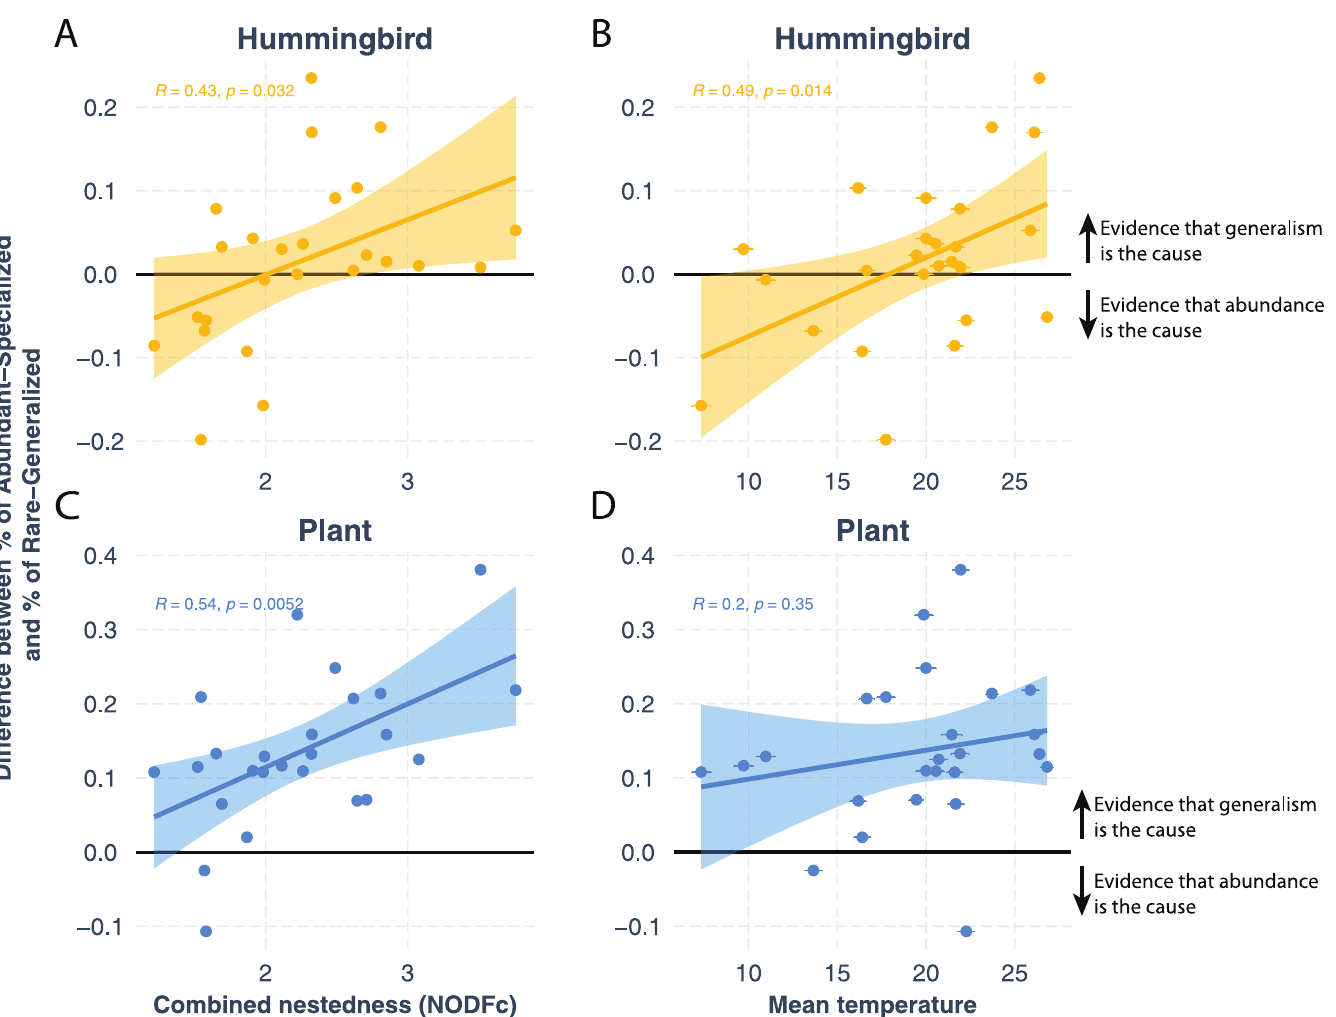
Fig 4. Strength of selection process versus drift process under structural and environmental context. Panels ( A ) and ( C ) show the effects of the structural context. The x axis shows the combined nestedness, which is an unbiased metric to compare the level of nestedness across networks [47, 50]. The y axis shows the differences between the proportion of abundant and specialist species and that of rare and generalist species. A positive difference indicates that generalism is the cause of abundance (i.e., stronger selection and weaker drift), while a negative difference indicates that abundance is the cause of generalism (i.e., weaker selection and stronger drift). Each point denotes a different empirical plant-humming bird community (i.e., dataset). The orange points represent the hummingbird data while the blue points represent the plant data. The strength of the selection processes increases as the communities have more nested structures for both plants and hummingbirds. Plants exhibit stronger positive patterns than hummingbirds under the structural context. Panels ( B ) and ( D ) show the effects of the environmental context. The x axis shows the local annual temperature mean where the community was sampled. The error bar represents 1 standard deviation with temperature mean from 1958 to 2020 [53]. The strength of the selection processes increases as the communities experience higher mean temperature for both plants and hummingbirds. Hummingbirds exhibit stronger positive patterns than plants under the environmental context. The Pearson correlations and their p values are shown in the figure.